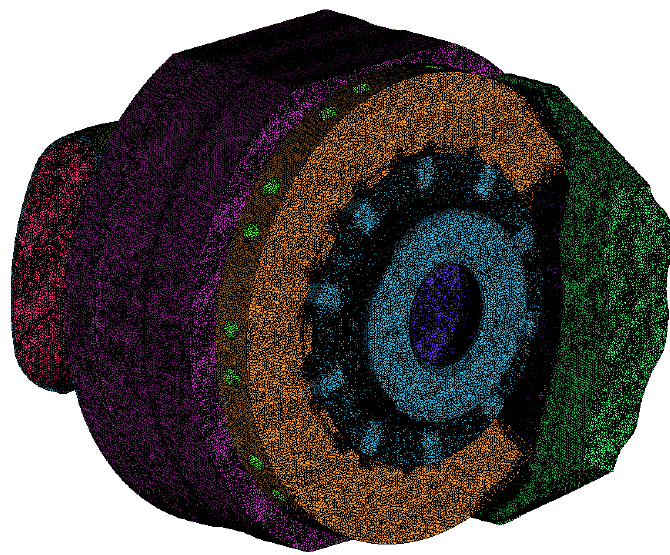
Figure 4. Mesh details of the brake system.